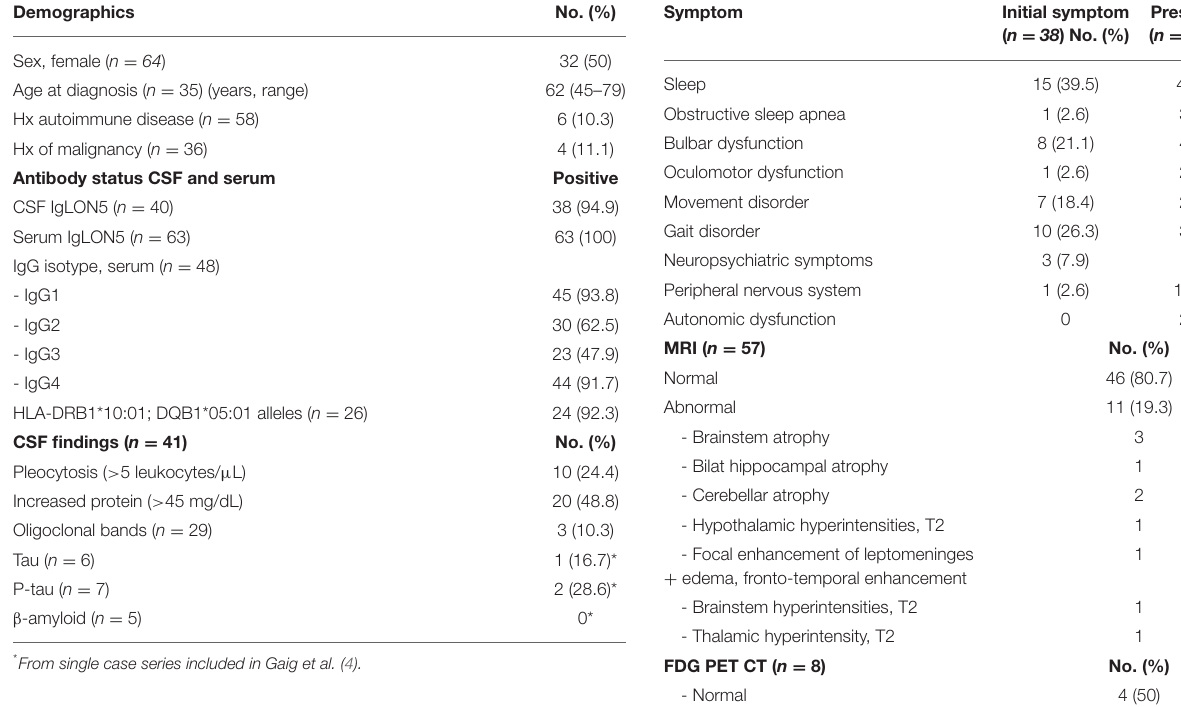
TABLE 2 | Symptoms at onset vs. during disease and imaging findings. Symptom